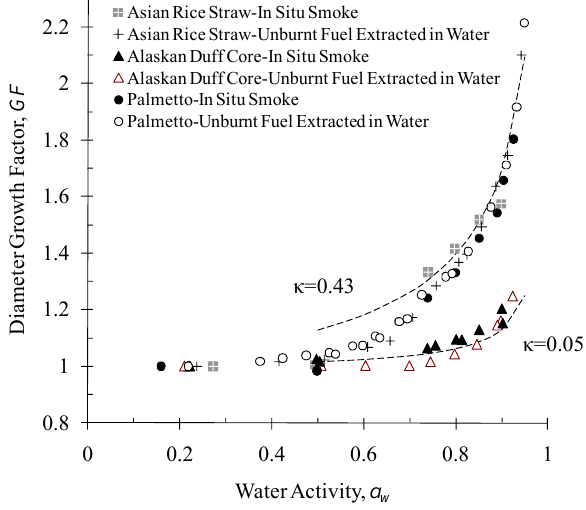
Fig. 9. HTDMA-measured ensemble hygroscopic growth curves for in-situ smoke particles and for particles generated from aqueous extracts of unburned fuels, for three biomass fuels. In all cases, D d =100 nm.